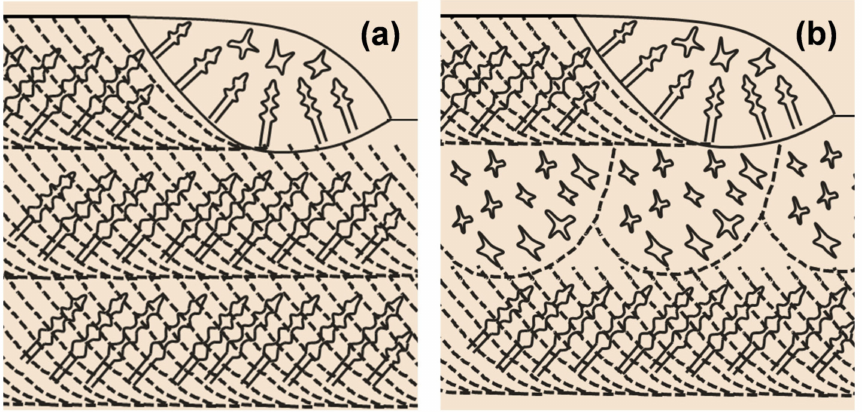
Figure 8. Schematic diagrams showing microstructural formation in QCW-LAM under different processing conditions: ( a ) SDS and ( b )